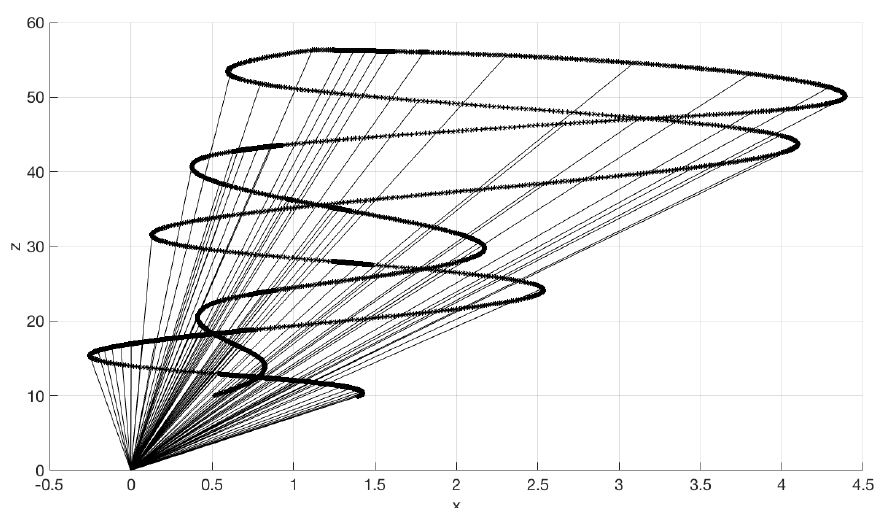
Figure 5. The optimal trajectory in 2D.